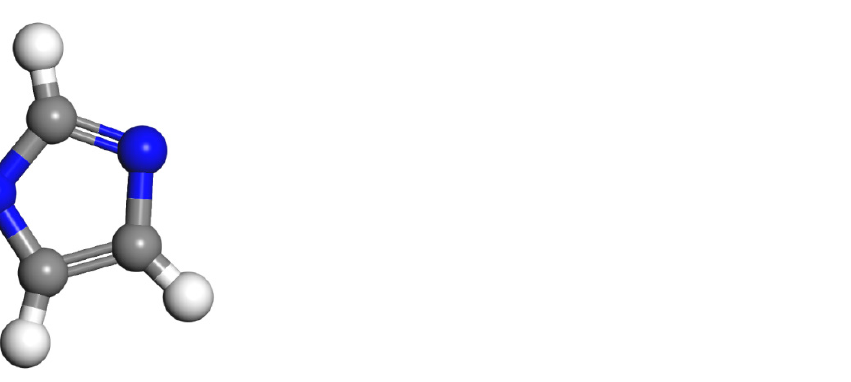
Figure 3. The model of E-51( n = 0; colour legend: hydrogen H (white); oxygen O (red); carbon C (grey)).